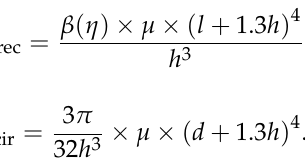
Figure 7. Damping coefficient of simulation results, fitting formulas, and the deviations between them for the ( a ) rectangular plate and ( b ) circular plate considering the finite size effect only when the air film thickness is 0.6 mm.